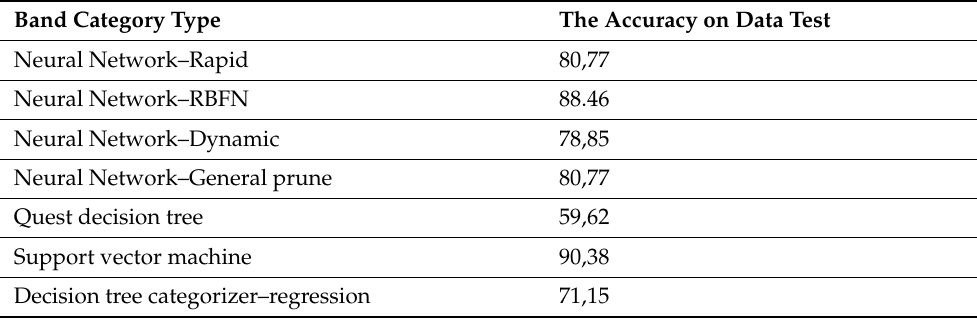
Table 4. Evaluation of obtained clusters for signaling